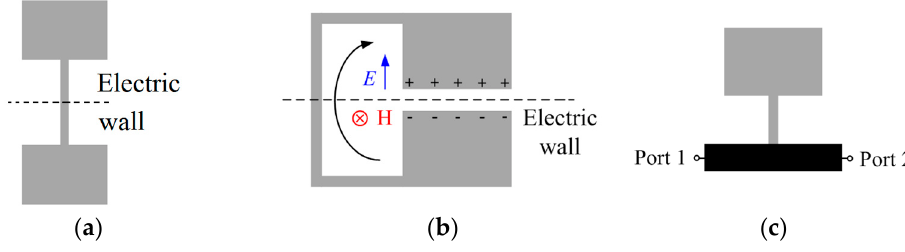
Figure 1. Typical topology of a tri-section stepped impedance resonators (SIR) ( a ), folded-SIR ( b ) and stepped impedance shunt stubs (SISS) attached to a microstrip line (depicted in black color) ( c ). The symmetry planes (for a and b ), corresponding to an electric wall at the fundamental resonance, are indicated.